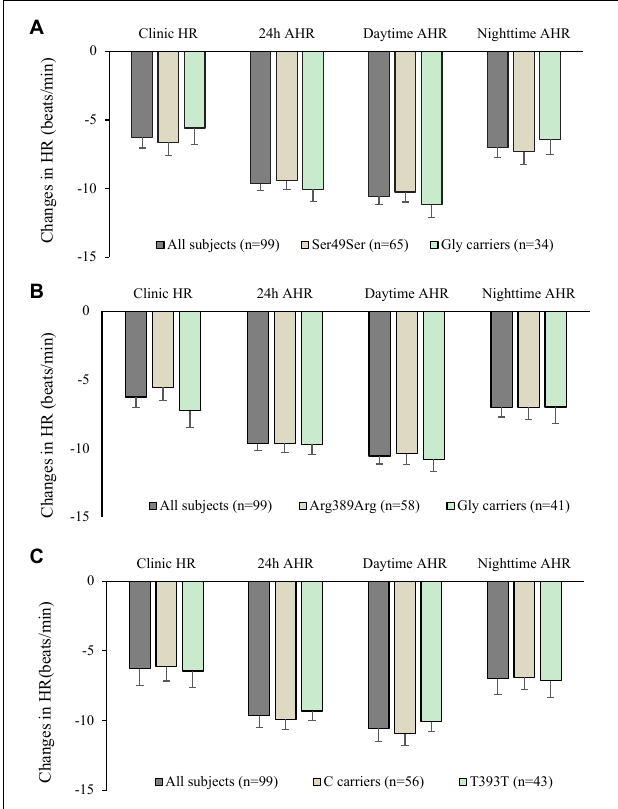
FIGURE 3 | Changes in clinic heart rate (HR) and ambulatory heart rate (AHR) after 6 weeks treatment with bisoprolol 2.5 mg daily according to (A) ADRB1 Ser49Gly genotypes, (B) ADRB1 Arg389Gly genotypes, and (C) GNAS 393C > T genotypes. Data are presented as mean ± SEM. There is no significant difference between groups (independent samples test was